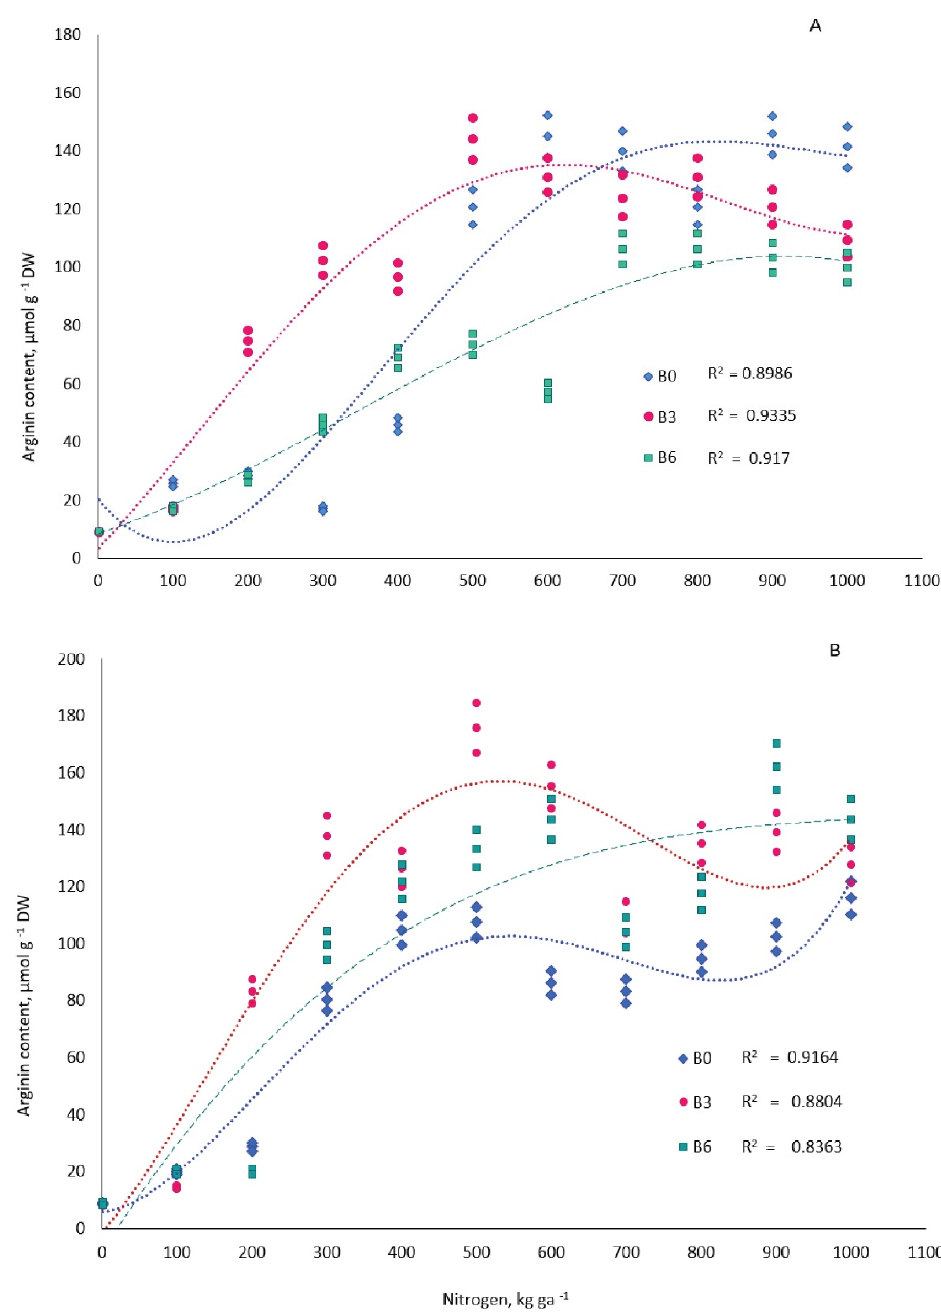
Figure 4. Dependence of the accumulation of arginine in the one-year-old needles of 16-year old Pinus sylvestris L. on the nitrogen fertilizers on three backgrounds of boron supply. B0, B3, B6—boron doses of 0, 3.0, 6.0 kg ha − 1 , respectively. ( A ) September 2014; ( B ) March 2015 (for regressive equation, see Table 4).